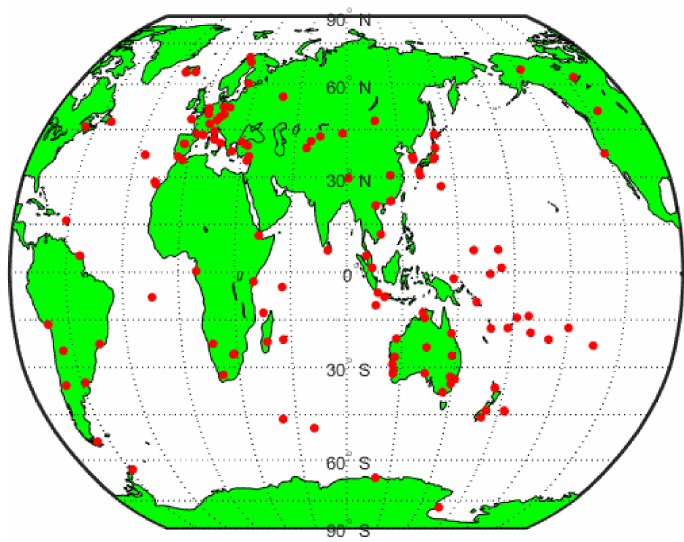
Figure 1. Distribution of the selected 140 IGS